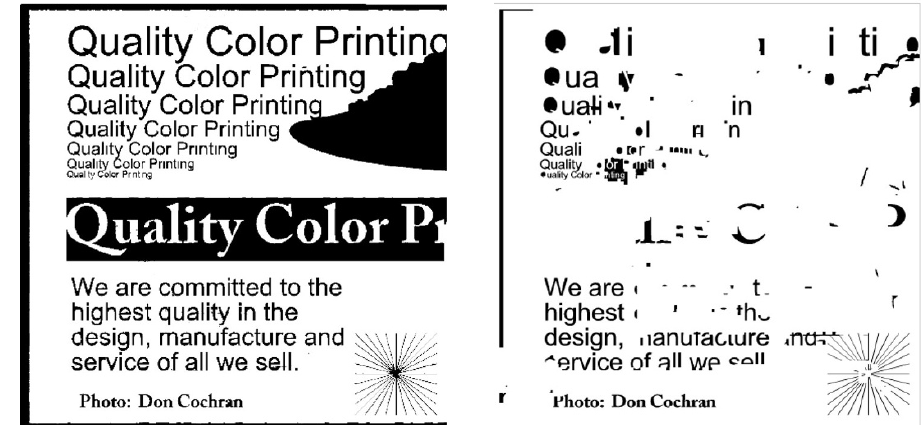
Figure 6: Comparison of the classification map generated by our algorithm (left) and the mask layer generated by DjVu algorithm (right) for